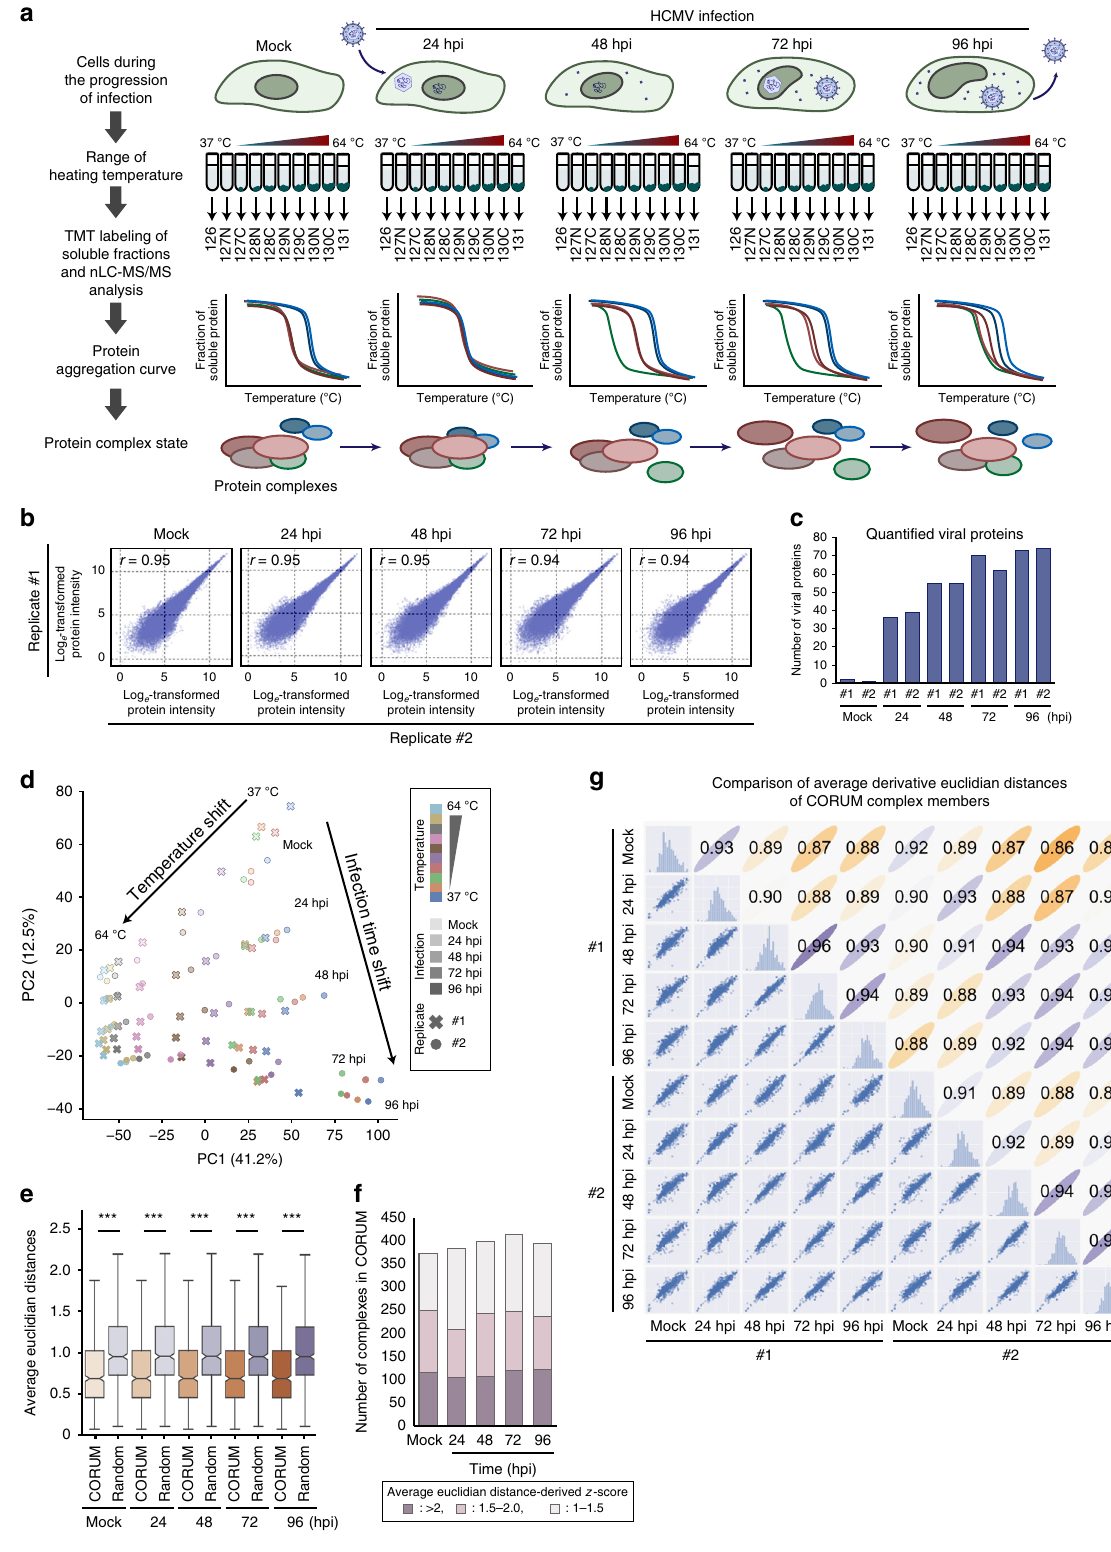
(Fig. 1f), and reproducible identi fi cation was re fl ected in the >0.93 correlation coef fi cient of the average Euclidean distance for each complex between replicates (Fig. 1g). Correlation coef fi cients gradually decreased from uninfected to late infection, suggesting the modulation of complexes during infection (Fig.